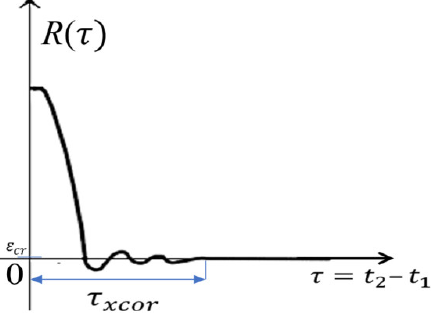
Figure 2. The autocorrelation interval. τ x ≈ τ xcor is the time interval between the values of the correlation function R ( τ = 0) and R ( τ xcor ) < ε cr , where ε cr is a small critical parameter steadily tending to zero ( ε cr → 0).